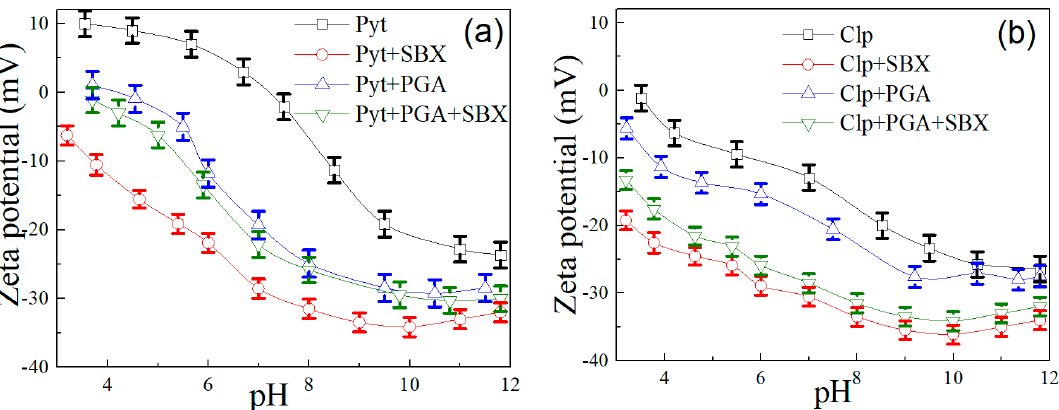
Figure 6. Zeta potential results of ( a ) pyrrhotite (Pyt) and ( b ) chalcopyrite (Clp) at 50 mg / L PGA and 20 mg / L SBX.